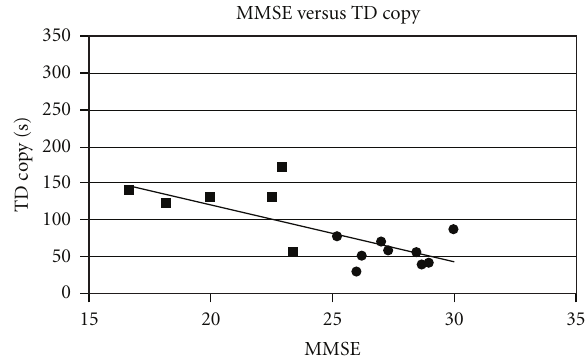
Figure 4: Relation between the MMSE scoring and duration in the CDT copy condition ( r = − 0 . 81). Squares are PDD, circles are